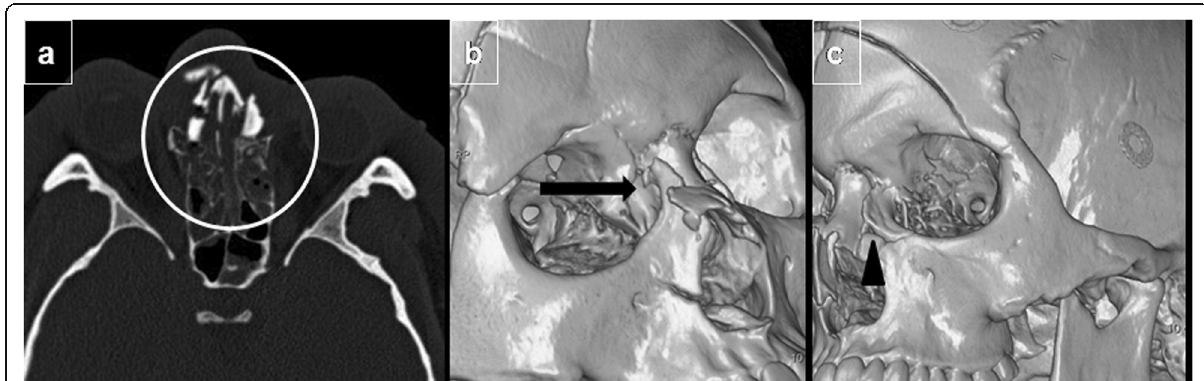
Fig. 10 Bilateral naso-orbito-ethmoidal fracture. a Axial unenhanced CT image at the level of the mid-orbit shows a comminuted fracture of the naso-orbito-ethmoid complex (circled) resulting in telecanthus (widened intercanthal distance). b , c Oblique 3D reconstructions to assess the insertion of the medial canthal tendon on the bones of the lacrimal fossa: more significant comminution with an avulsed fragment can be seen on the right (arrow) than on the left side (arrowhead)